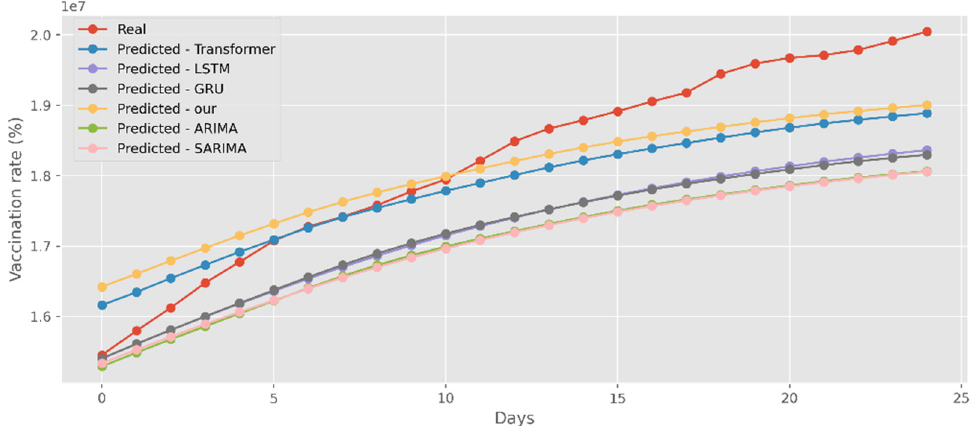
Figure 18. Comparison of COVID-19 prediction models of vaccinated in CA.